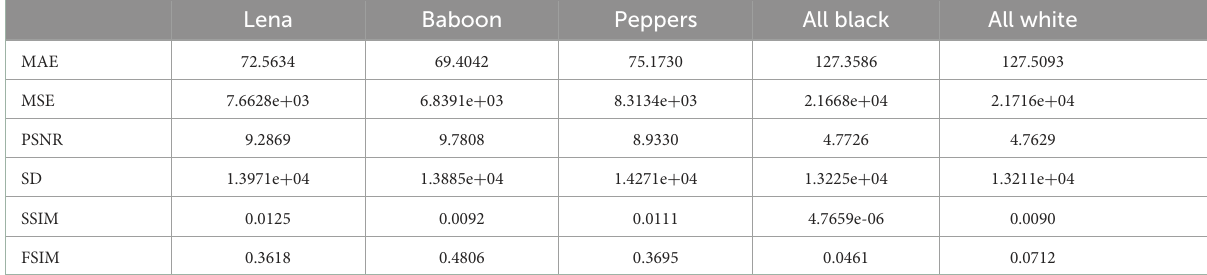
TABLE 12 Perceptual quality metrics. Lena Baboon Peppers All black All